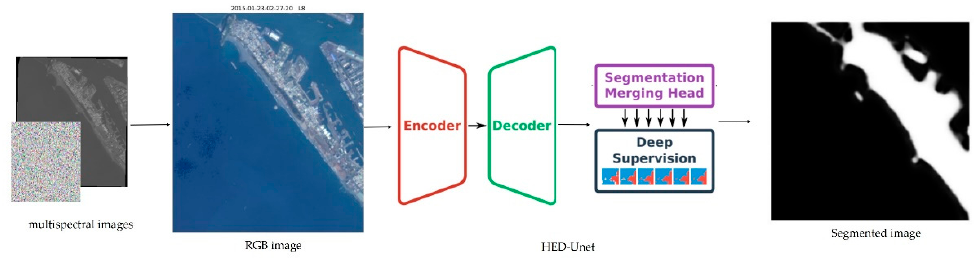
Figure 5. High-level structure of sea–land segmentation system with HED-Unet [3].